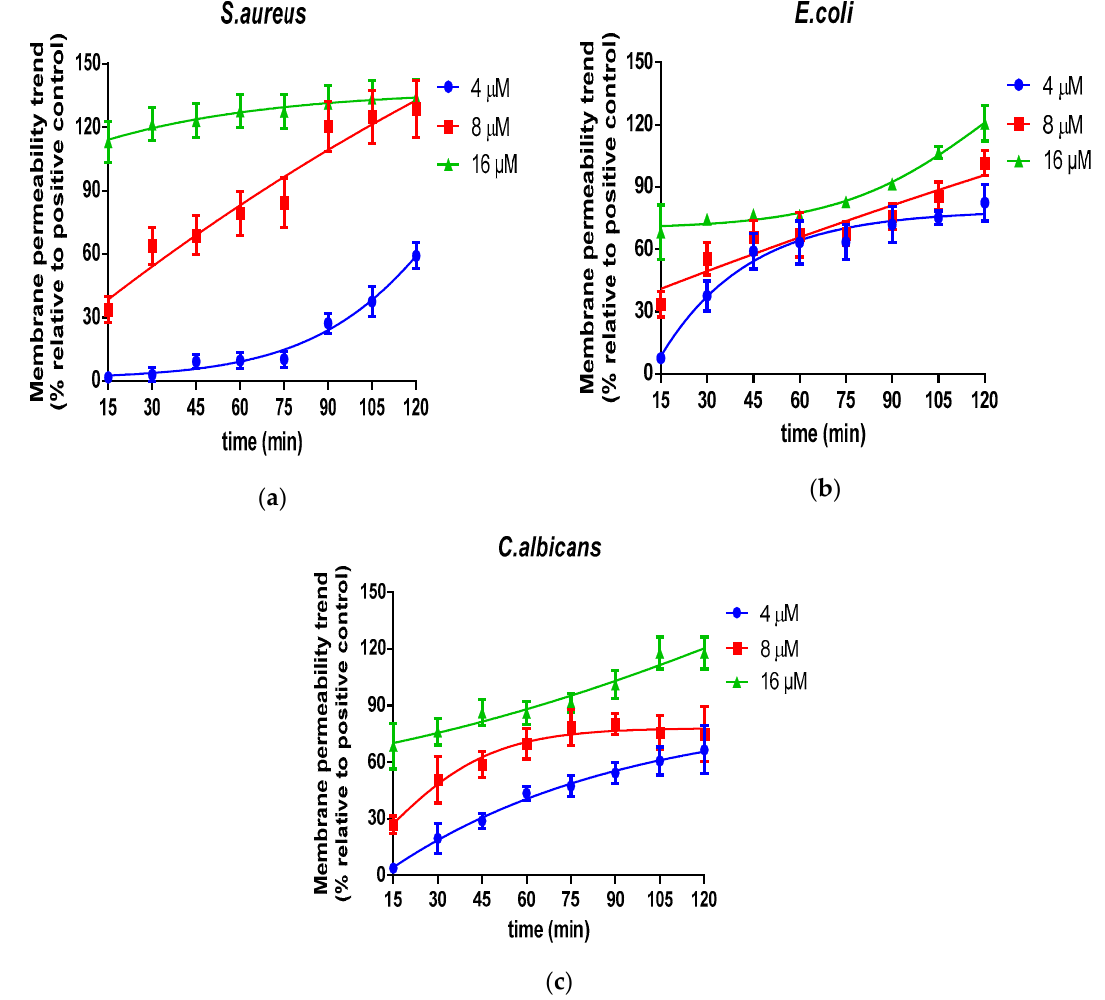
Figure 8. The time-curve of cell-membrane permeabilized activities of Der-PS4 were performed on S. aureus ( a ), E. coli ( b ) and C. albicans ( c ) in a range of concentrations based on the results of end-point on 120 min. The fluorescence was measured every 15 min. Positive control was acquired after incubation with 70% isopropanol. Data represent means ± SEM (stand error of the mean) of five replicates.